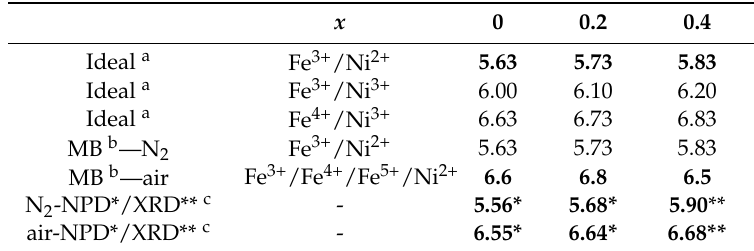
data. Matching data are written in